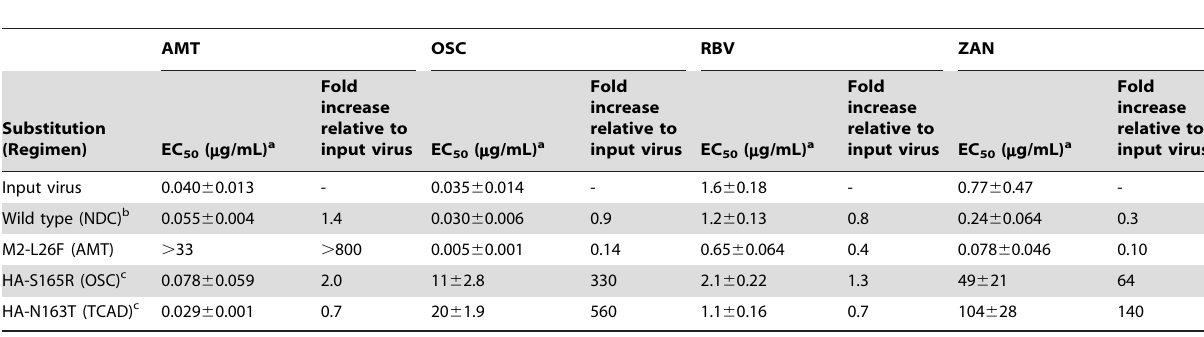
Table 4. Susceptibility of Virus Clones to AMT, OSC, RBV and ZAN as Single Agents.